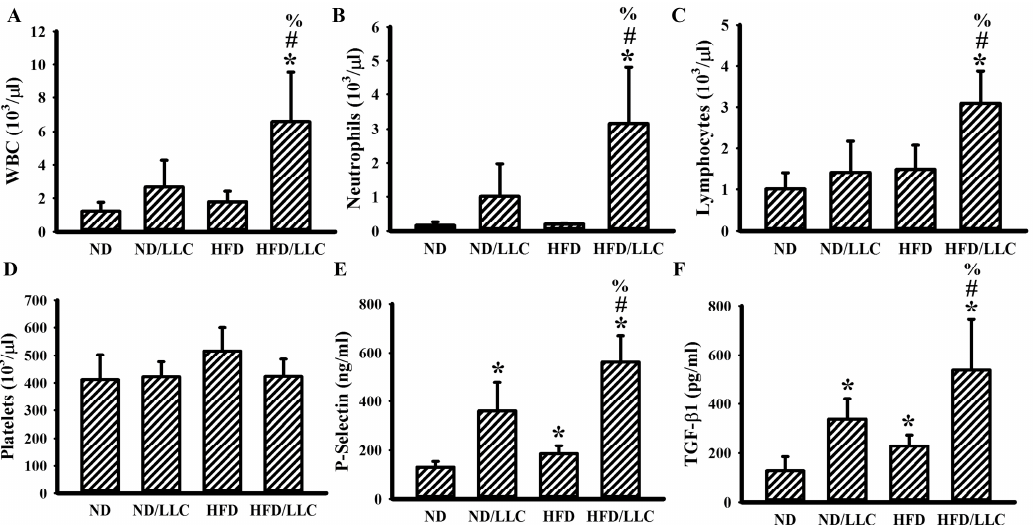
Figure 3. Tumor growth augmented inflammation in obese mice. LLC cells (LLC) or saline vehicle were implanted into the lean (ND) and obese (HFD) mice and grew for 2 weeks. The total white blood cells (WBC) ( A ), neutrophils ( B ), lymphocytes ( C ), platelets ( D ), soluble P-selectin ( E ), and Transforming Growth Factor- β 1 (TGF- β 1) ( F ) in blood samples were determined. * p < 0.05 vs. ND, % p < 0.05 vs. ND/LLC, and # p < 0.05 vs. HFD (n = 5 per group).